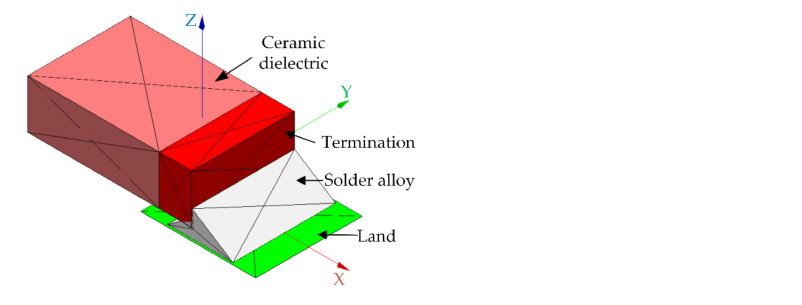
Figure A2. The initial shape of the solder is established in the surface